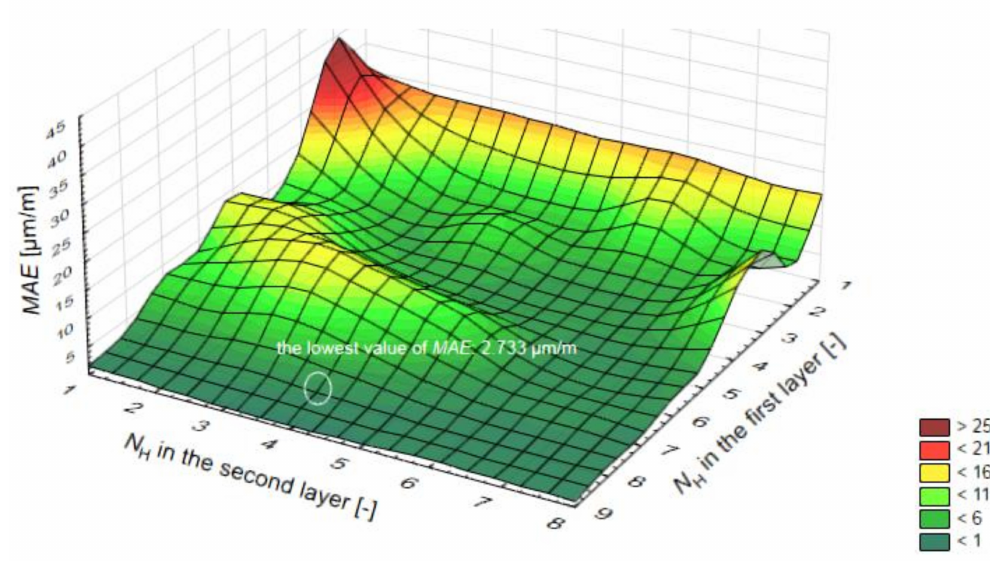
Figure 4. Results of mean absolute error (MAE) for different topologies of ANN models.